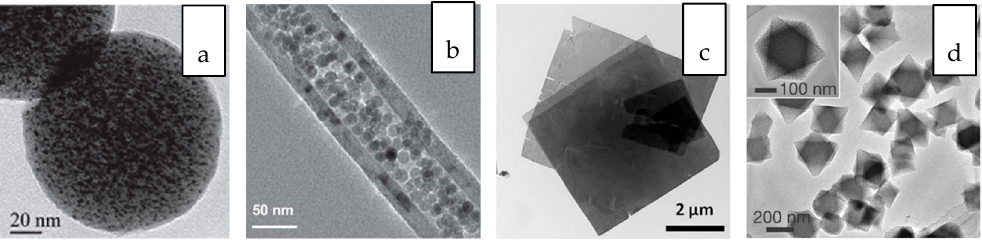
Figure 2. Transmission electron microscope (TEM) images of ( a ) 0D platinum loaded N-doped mesoporous carbon nanosphere [34], ( b ) 1D iron oxide nanoparticle filled carbon nanotube [35], ( c ) 2D metal organic framework nanosheet [36] and ( d ) 3D platinum loaded in between a MIL-101(Cr) core and MIL-101(Fe) shell [37].